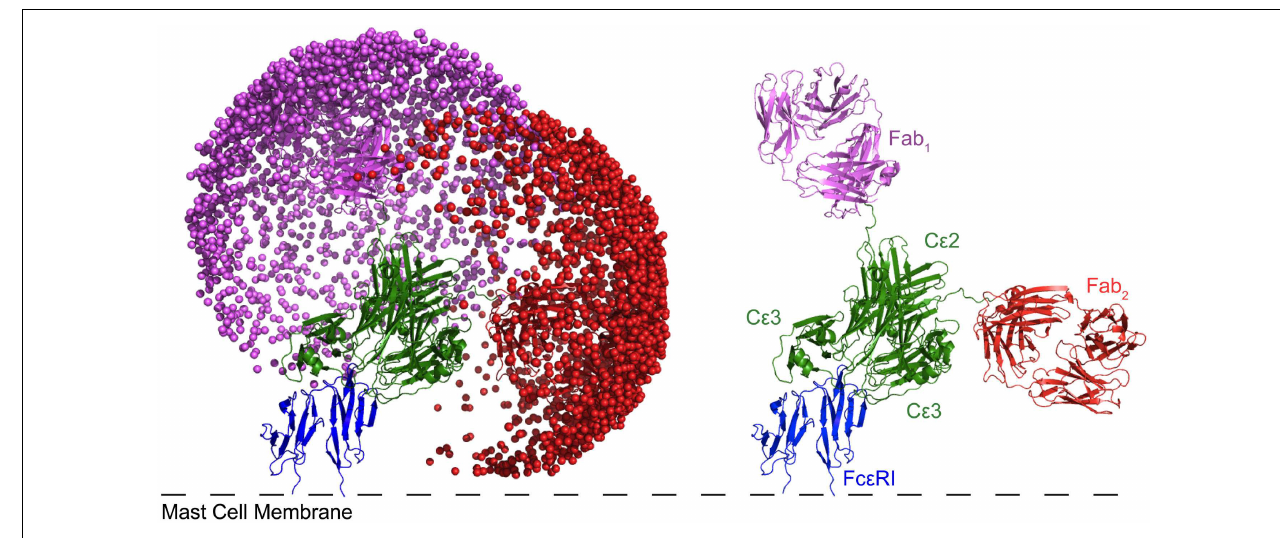
observed restricted mobility of Fabs on IgE relative to IgG, but also suggests that two neighboring IgE-Fc ε RI complexes are pre-disposed for ready cross-linking either by self-association or through a bridging protein. For more details of modeling see Hunt et al.